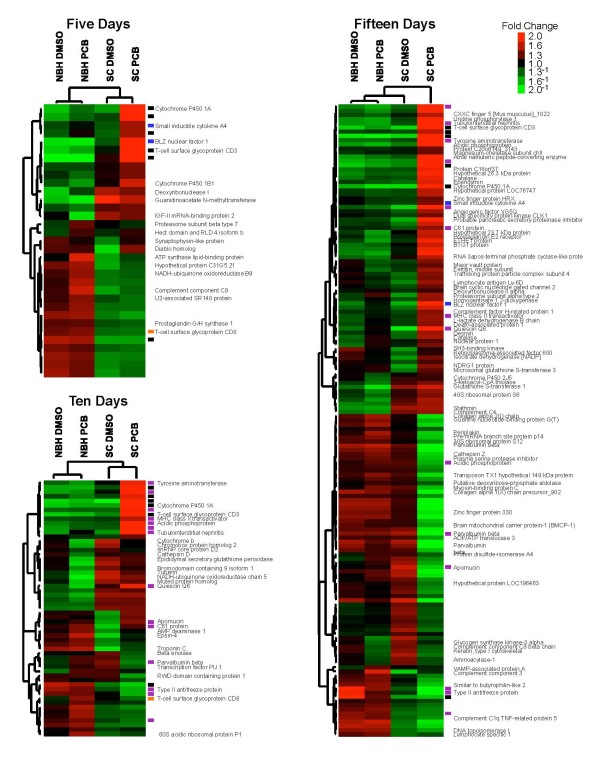
Heat map illustrating results of hierarchical clustering of the genes whose expression is significantly different due to population, treatment and population-by-treatment interactions at 5, 10, and 15 days post-fertilization. Clusters of genes with similar expression patterns are shown on the left (gene tree). Red indicates high expression levels and green represents low expression levels. Black rectangles denote genes significantly differently expressed at 5, 10, and 15 days post-fertilization. Orange rectangles denote genes significantly differently expressed at 5 and 10 days post-fertilization. Blue rectangles denote genes significantly differently expressed at 5 and 15 days post-fertilization. Purple rectangles denote genes significantly differently expressed at 10 and 15 days post-fertilization. Unlabeled rectangles represent unannotated genes.